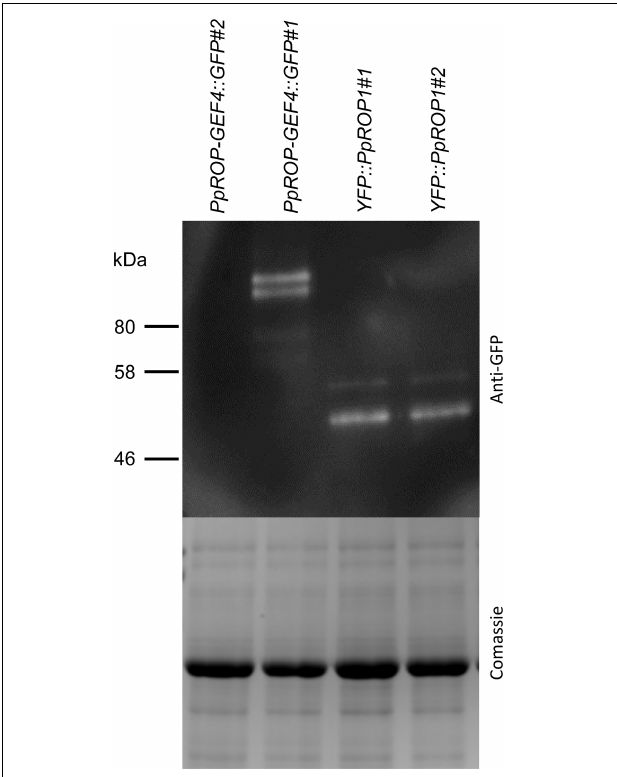
FIGURE 6 | PpROP-GEF4::GFP and YFP::PpROP1 protein levels in “knock-in” protonemata. Total proteins extracted from PpROP-GEF4::GFP and YFP::PpROP1 protonemata were separated by SDS-PAGE and either analyzed by immunoblotting using an anti-GFP antibody (upper panel; chemiluminescence detection), or coomassie stained to show equal loading of all lanes (lower panel). Predicted sizes of PpROP-GEF4::GFP and YFP::PpROP1 are 91 and 50 kDa,